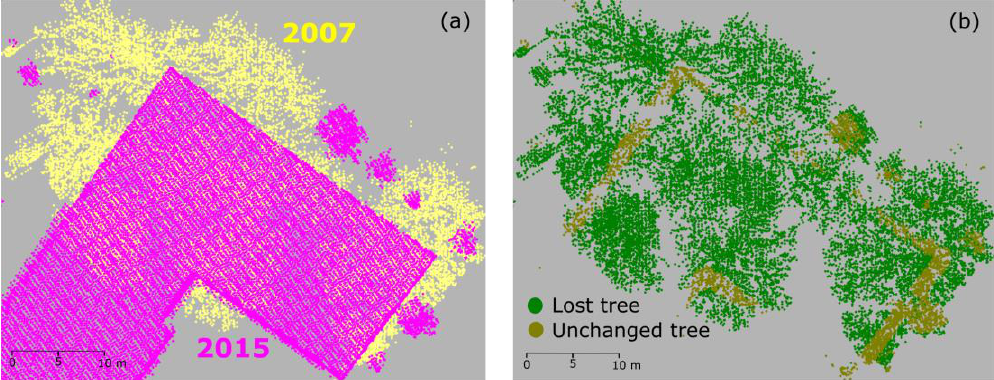
Figure 12. Example of misclassification in the case of object with adjacent old and new data: ( a ) data in 2007 and 2015; and ( b ) misclassification results in 2007. In the intersection of the objects, points are misclassified as unchanged trees.